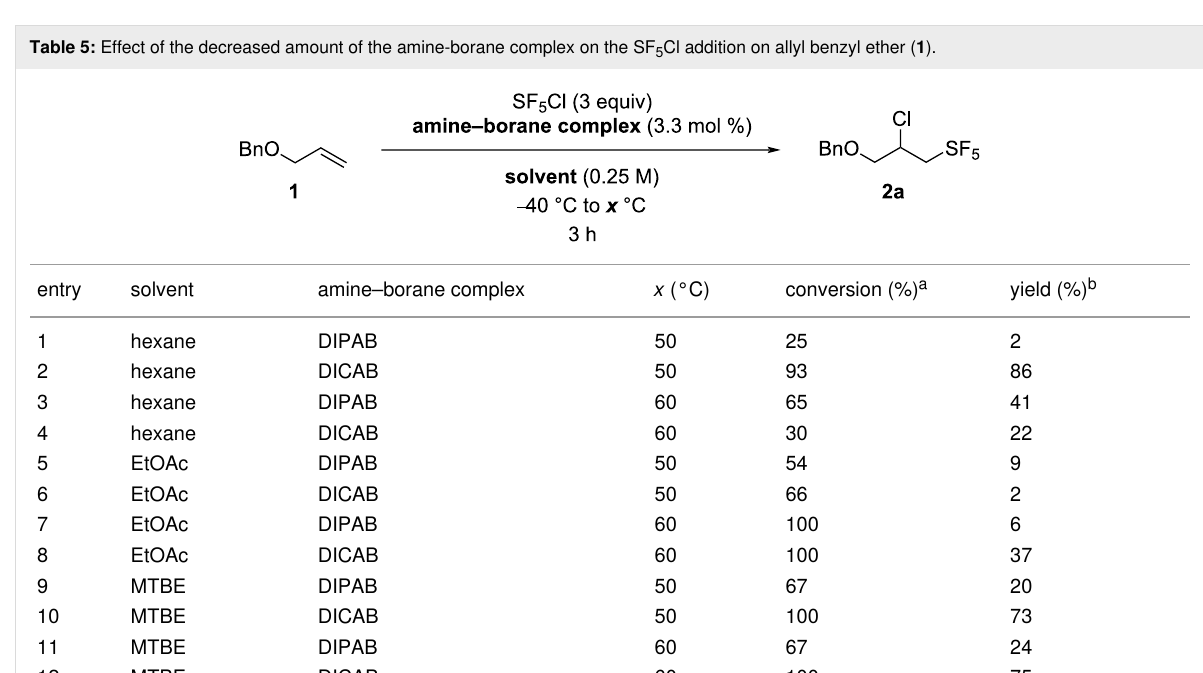
Table 5: Effect of the decreased amount of the amine-borane complex on the SF 5 Cl addition on allyl benzyl ether ( 1 ).